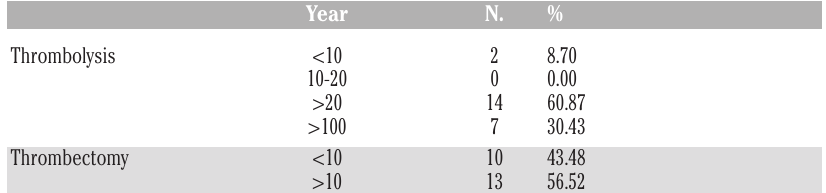
Table 1. Volume (%) of thrombolysis and thrombectomy in participating hospitals.